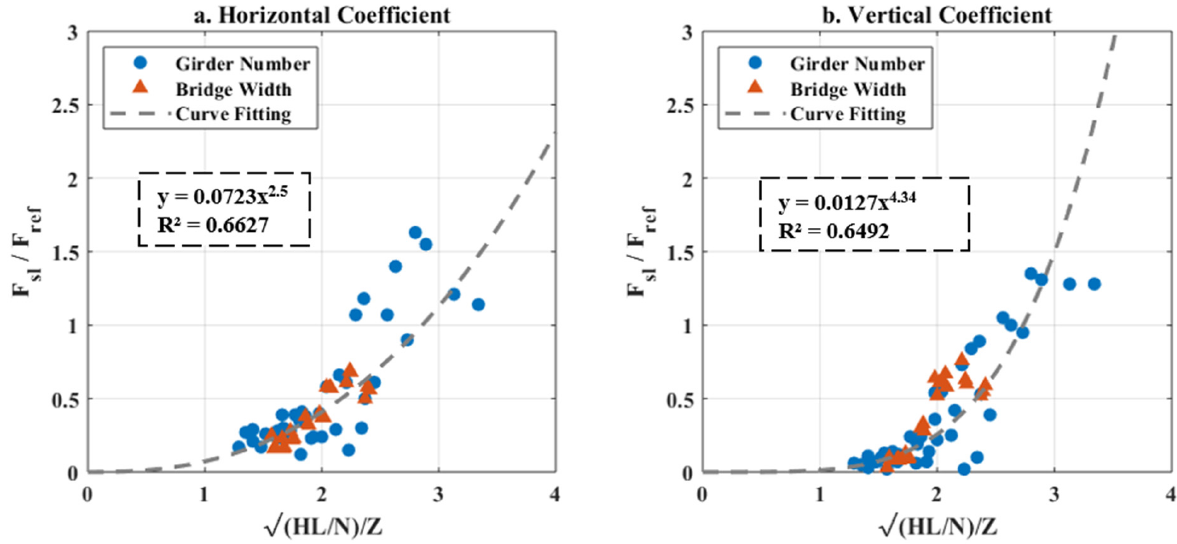
Figure 21. Regression analysis of the maximum wave forces predicted by the simulations over the reference wave force, as function of the unitless parameter √ ( HL / N )/ Z .